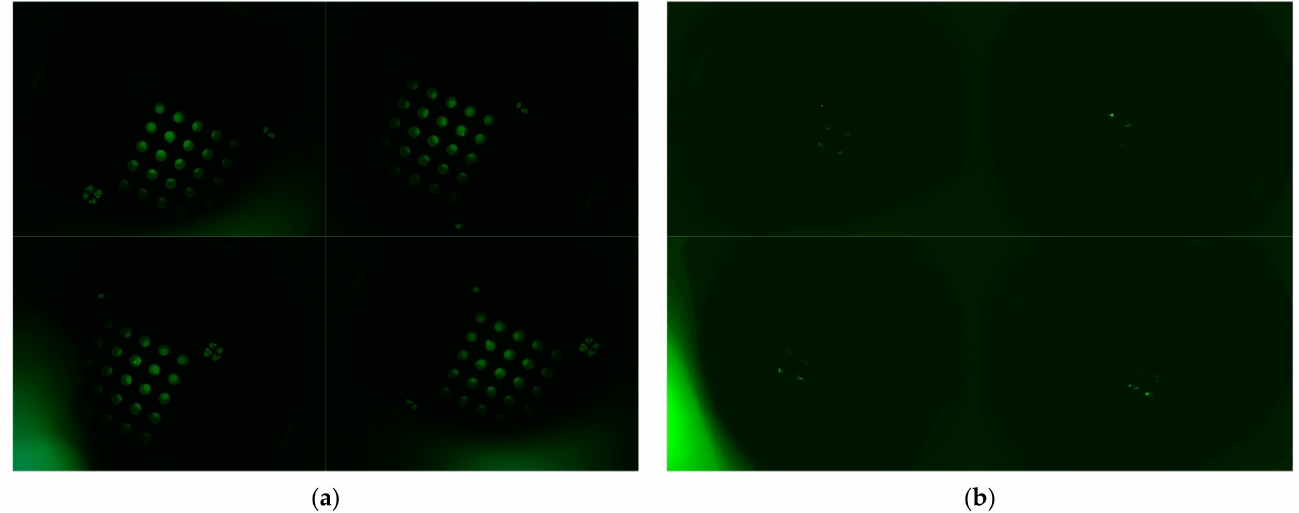
Figure 7. Four images divided into quadrants: ( a ) FAM; ( b ) DDW (Increased by a factor of six).